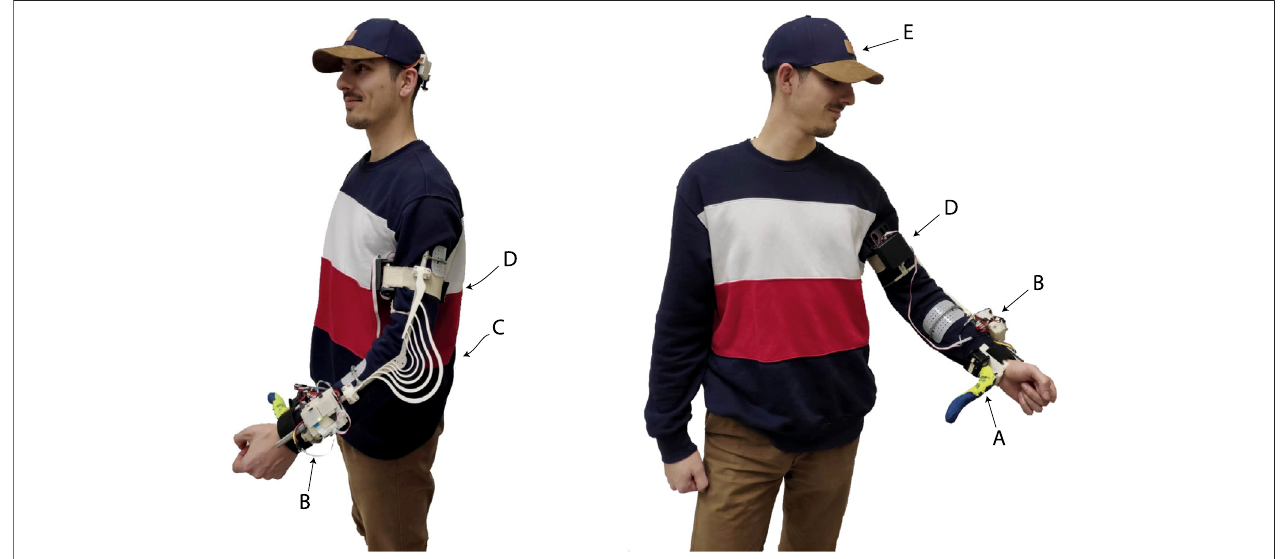
FIGURE5| TheRoboticsixth fi nger (A) and its power supply and control system (B) ,developedby US, hasbeen integratedwiththe Assistive ElbowOrthosis (C) , developed by UT, and the CUFF (D) from UP. The CUFF has been modi fi ed to be completely wearable. Motion of the fi nger is controlled via a new e-Cap version (E) developed by US with novel 3D-printed electrodes by